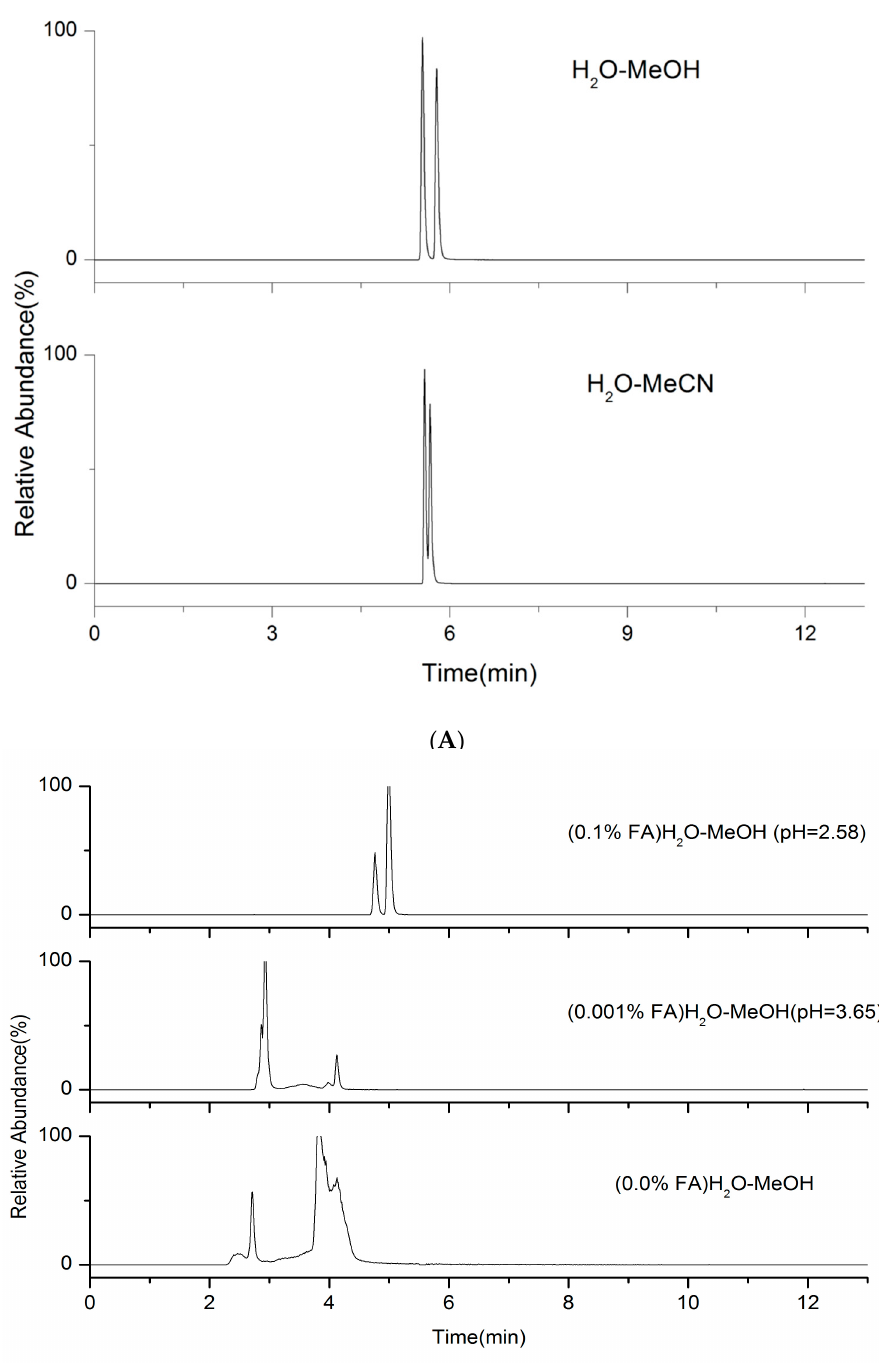
Figure 2. The effect of different mobile phases on the chromatographic separation of the isomers of atenolol and practolol. ( A ) Different organic solvents (atenolol:practolol = 2:1); ( B ) Different concentrations of FA in water phase (atenolol:practolol = 1:1).